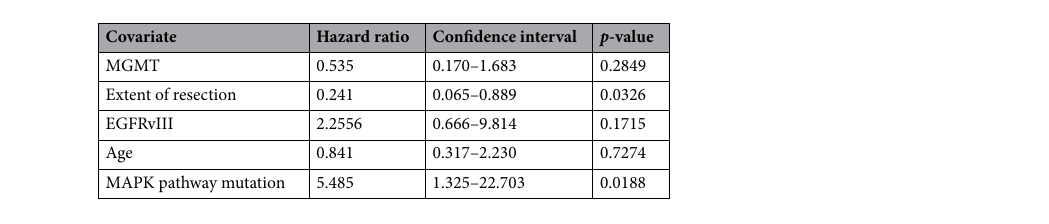
Table 1. Multivariate analysis of factor affecting progression-free survival in the whole cohort.